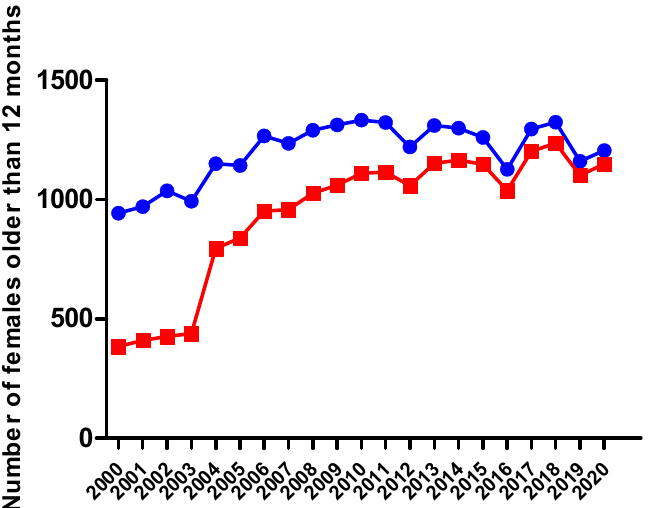
Figure 7. Evolution of total (blue filled circles) and BA females (red filled squares) older than 12 months from 2000 to 2020 in Andorra.